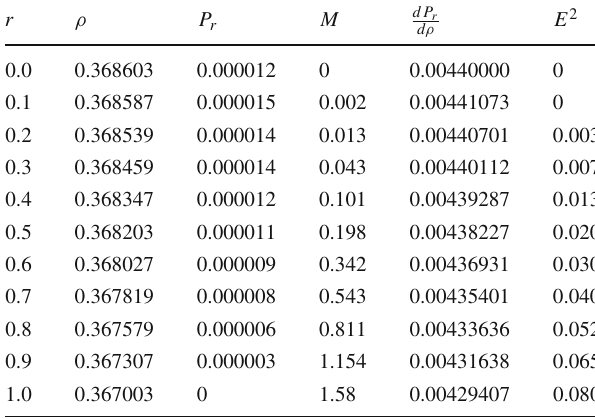
Table 2 Variation in physical parameters from center to the surface for the realistic star 4 U 1820 − 30